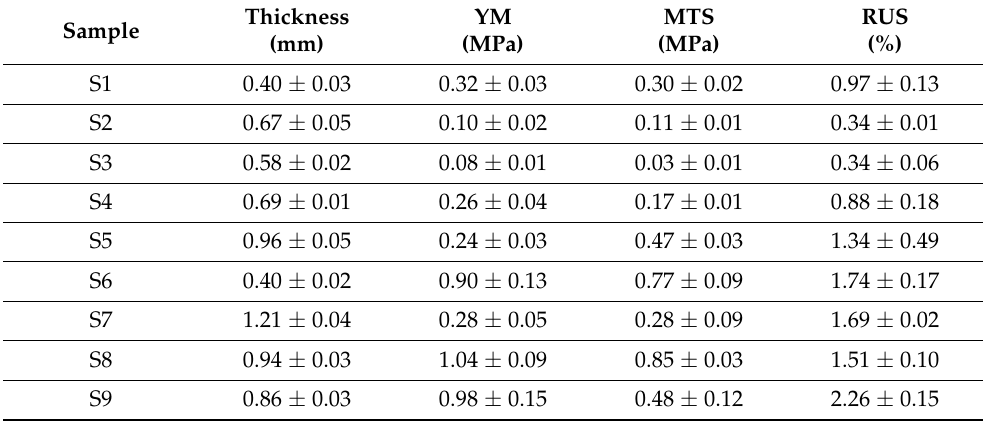
Table 2. Mechanical properties of SLGMs obtained using different synthesis conditions.